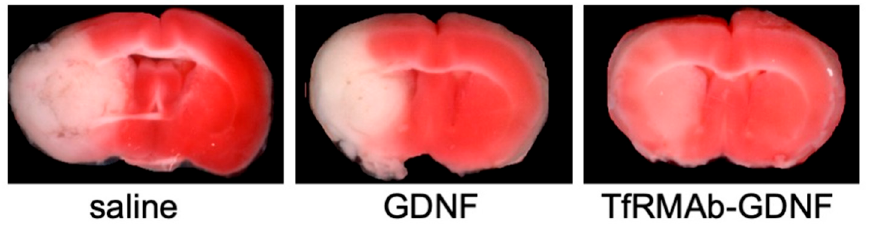
Figure 10. Neuroprotection of the mouse TfRMAb-GDNF fusion protein in a reversible middle cerebral artery occlusion (MCAO) stroke model. Brain coronal sections were obtained 24 h after MCAO and stained with 2,3,5-triphenyltetrazolium chloride (TTC), and representative brains are shown in the figure. Saline, 1 mg/kg BW mouse TfRMAb-GDNF fusion protein, and an equimolar dose of GDNF (0.17 mg/kg BW), were injected IV 45 min after MCAO. The mouse TfRMAb-GDNF fusion protein produced a 30% reduction in cortical stroke volume ( right ) compared with the control treated with saline ( left ), whereas GDNF alone had no effect on stroke volume ( center ). From [125] with